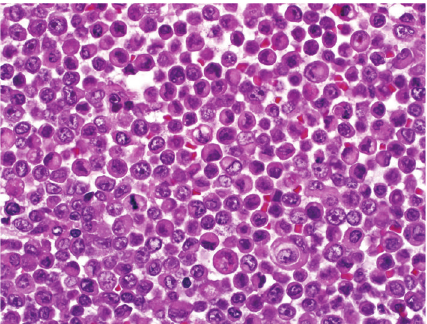
Figure 1: The classical “rhabdoid” morphology of the tumor comprising the cytoplasmic hyaline globules and the eccentric nucleus. Mitotic figures are also seen (H&E stain, magnification power × 400).